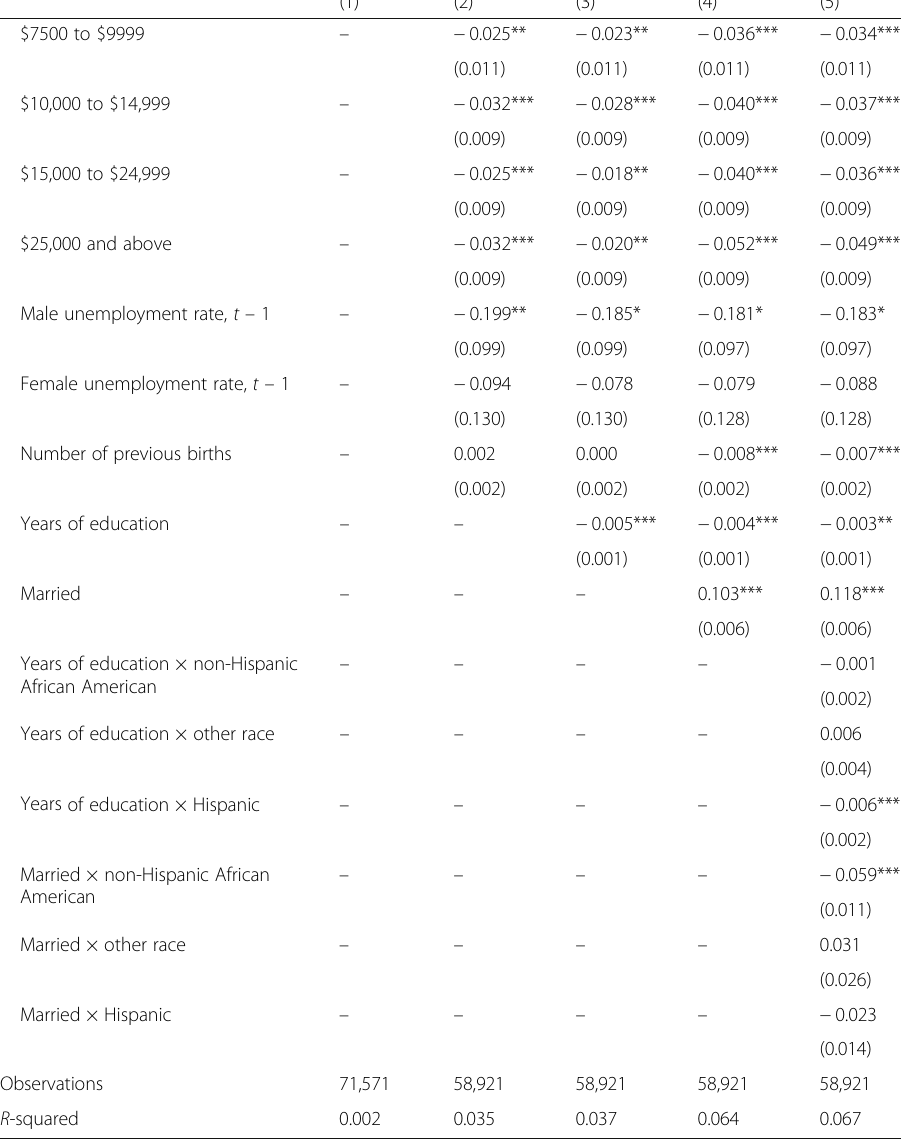
Table 6 Full set of coefficient estimates for Table 4 regressions